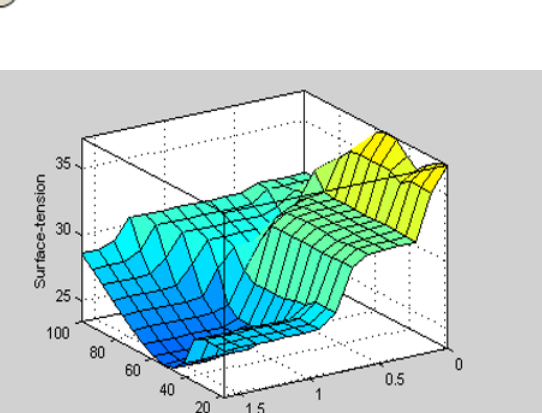
Figure 13. Absorbance variation with temperature and concentration.